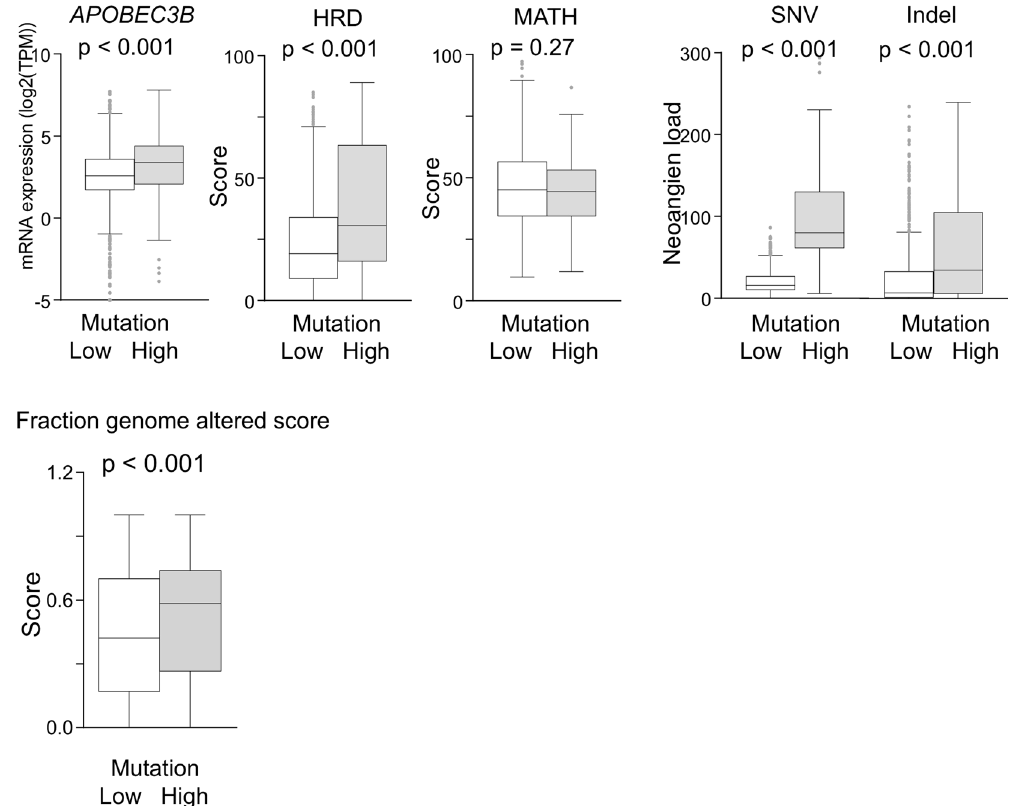
Figure 4. Tumors with high mutation rates were derived from not only APOBEC3B (p < 0.001), but also HRD (p < 0.001). Despite multiple mutation sources in the high mutation rate group, heterogeneity measured by MATH score (p = 0.27) was similar between two groups. Tumors with high mutation were associated with increased neoantigen loads, represented by SNV and Indel (p < 0.001, respectively). Fraction genome altered score was significantly elevated in tumors with high mutation rate. APOBEC3B, Apolipoprotein B mRNA editing enzyme catalytic polypeptide-like 3B; HRD, homologous recombination; MATH, Mutant Allele Tumor Heterogeneity; SNV, single nucleotide variant; Indel, Insertion and